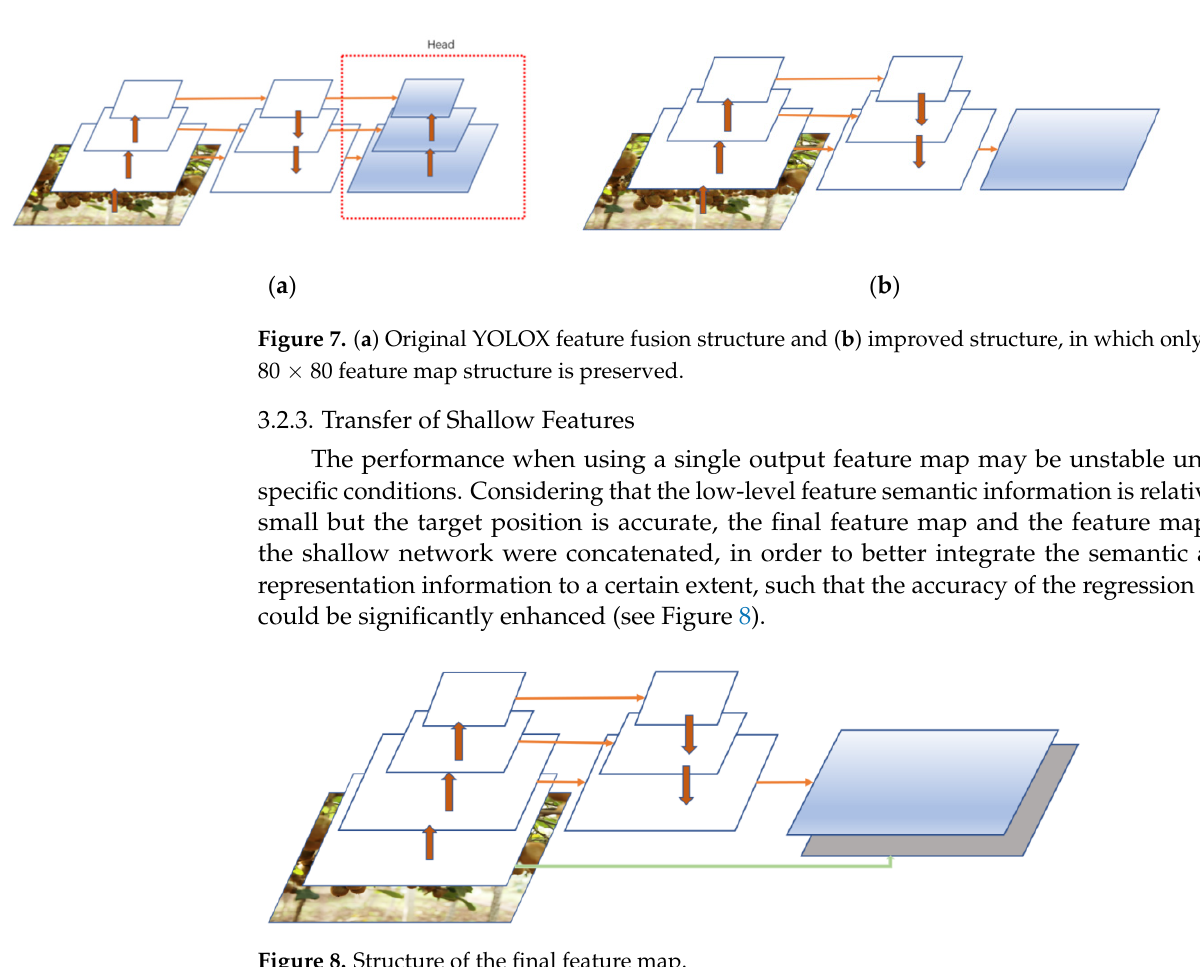
Figure 8. Structure of the final feature map.